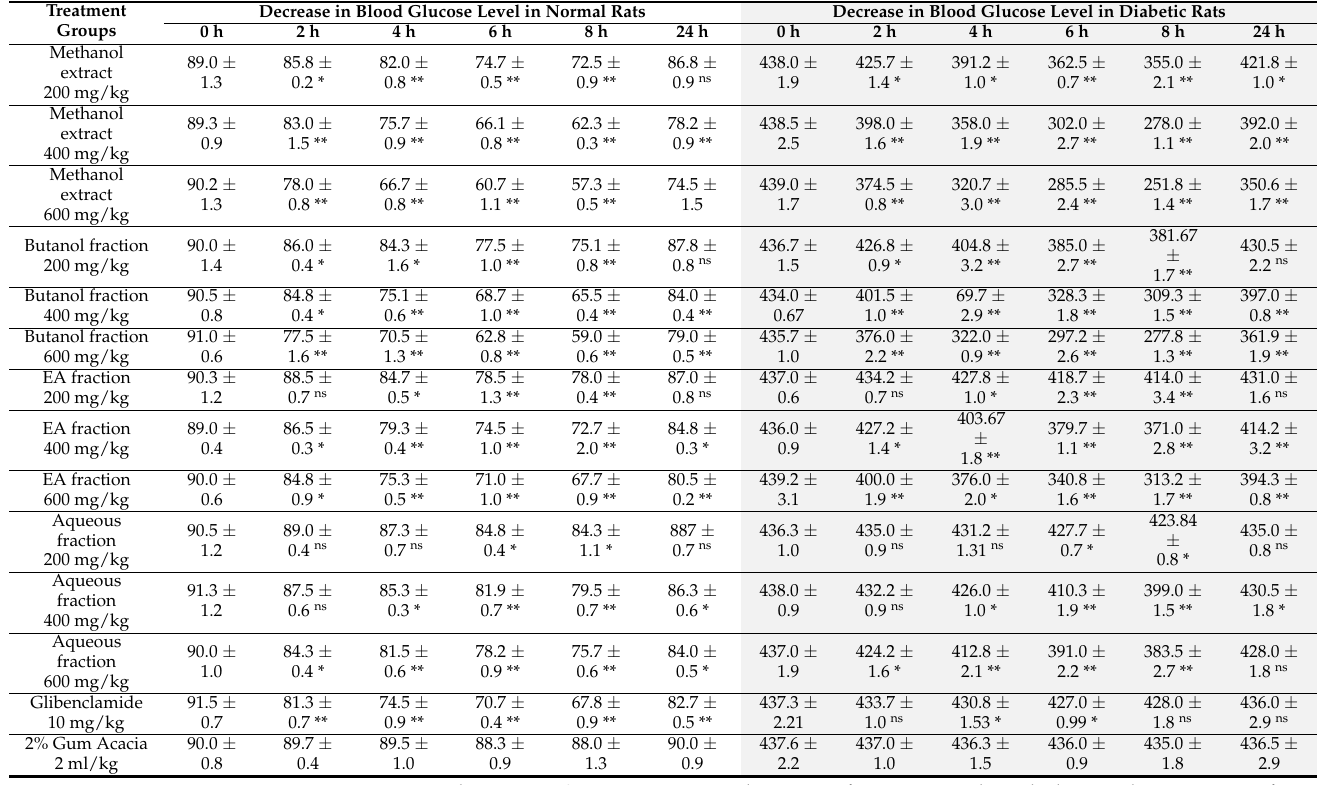
Table 4. Hypoglycemic effect of B. calliobotrys in normal and alloxan-induced diabetic rats.